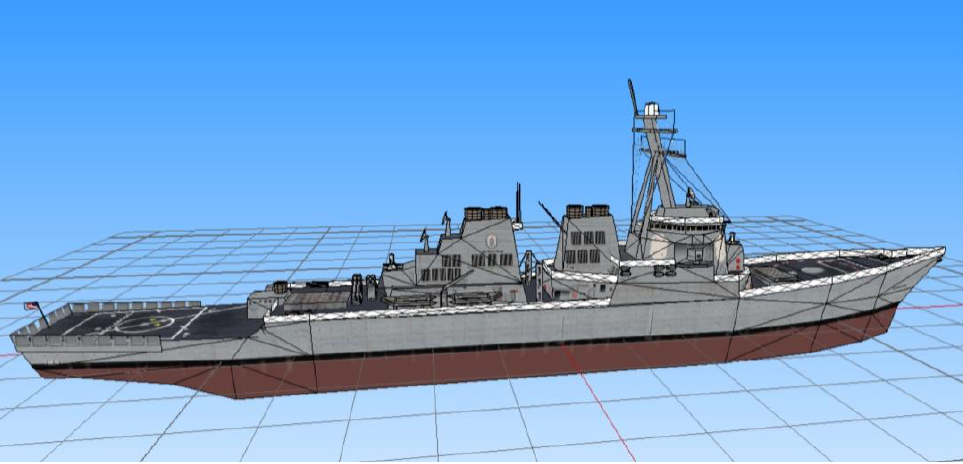
Figure 2. 3D modeling of ship target.